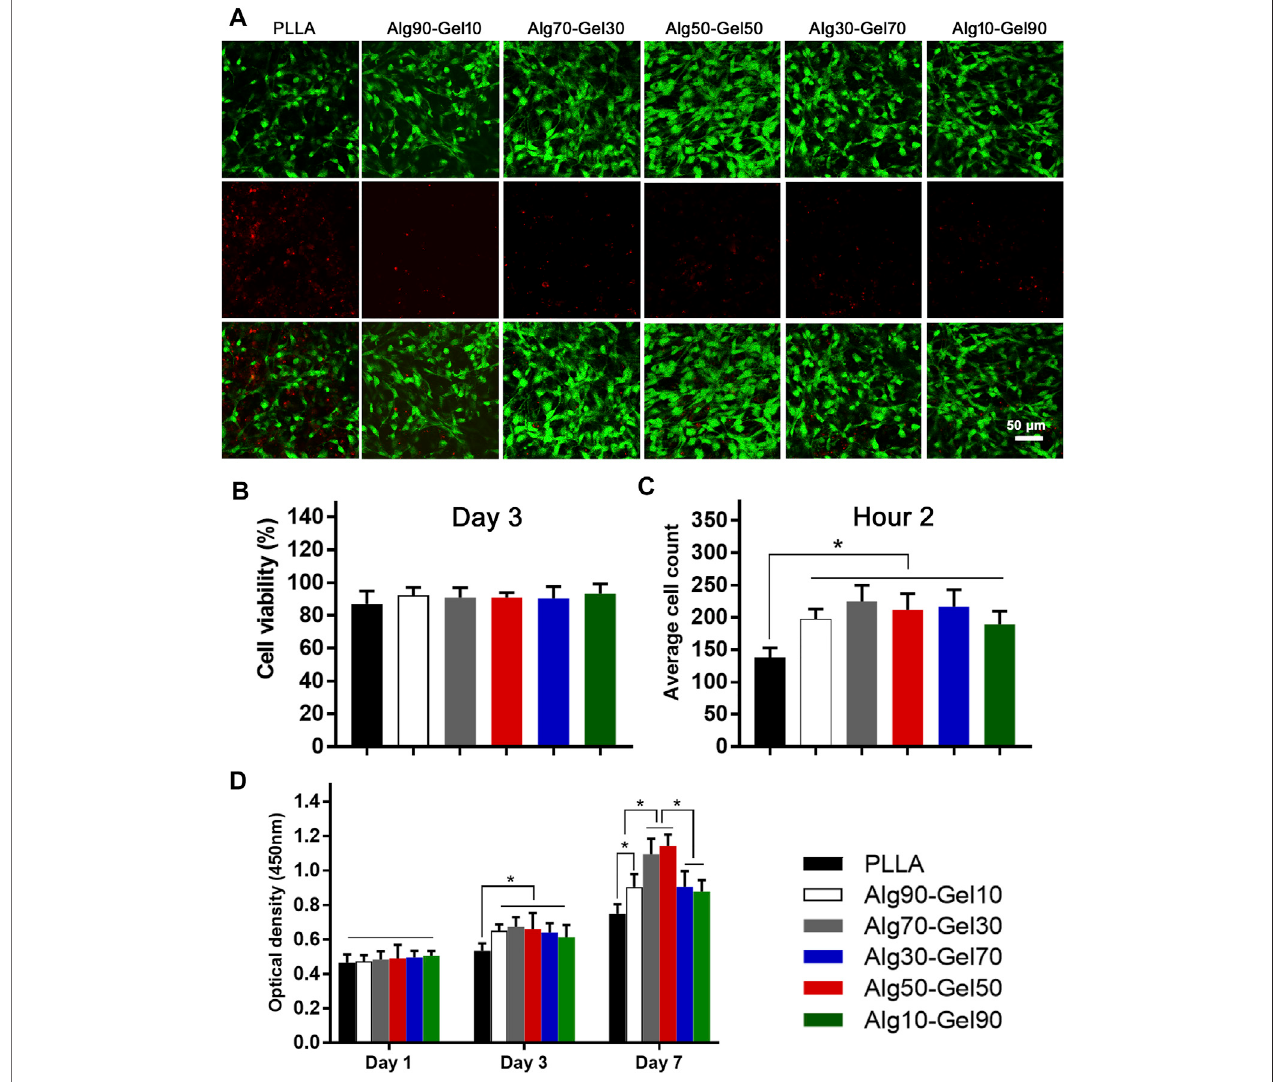
FIGURE 3 | (A) Cell viability of human bone mesenchymal stem cells (hBMSCs) on the different samples (scale: 50 μ m) and (B) statistical analysis. (C) The short- term cell adhesion at hour 2 and (D) cell proliferation at days 1, 3, and 7 on the PLLA and bilayer coatings (* p < 0.05 compared with the